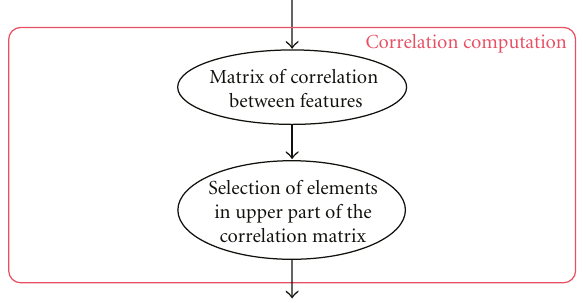
Figure 4: Details of the second part of the analysis system.